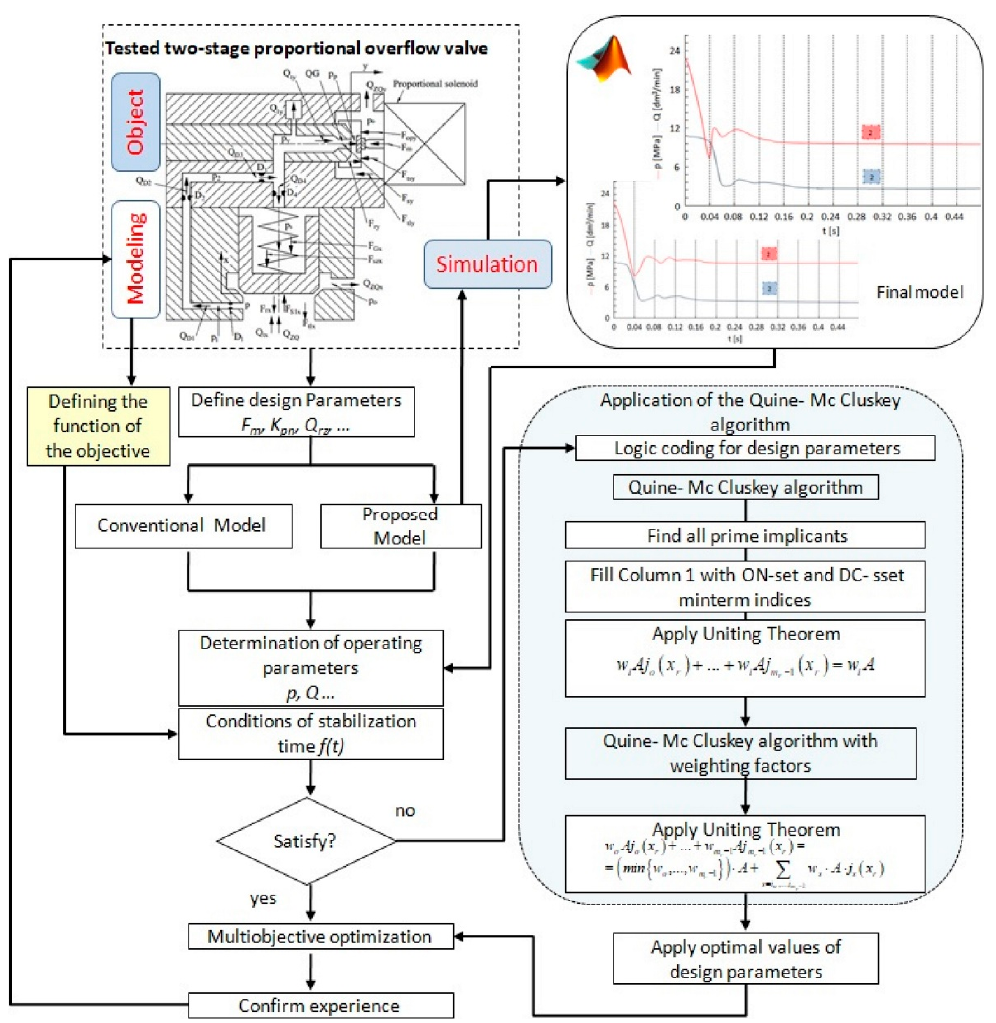
Figure 8. Flow chart of the proposed method (with example runs for the weighting factor w i = 2)